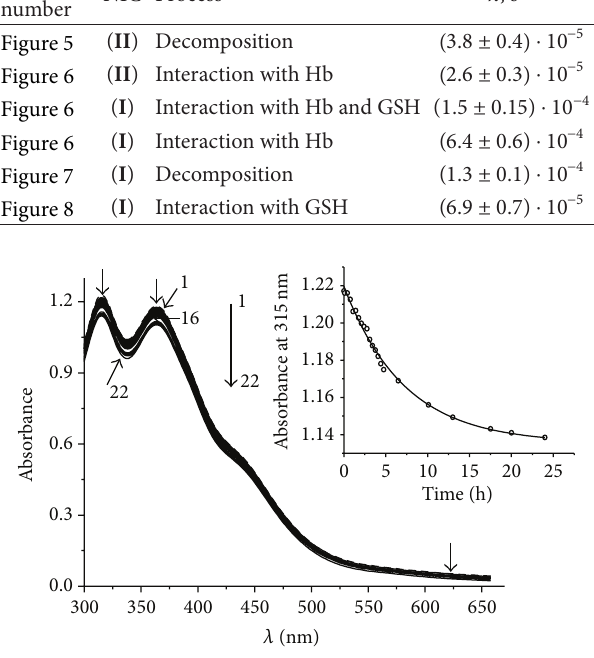
Figure 5: Kinetics of change of absorption spectrum of ( II ) ( 1.5 ⋅ 10 −4 M): spectra were registered at 30 s (1) , 5 (2) min after start of reaction. Spectra 3–16 were registered further with interval